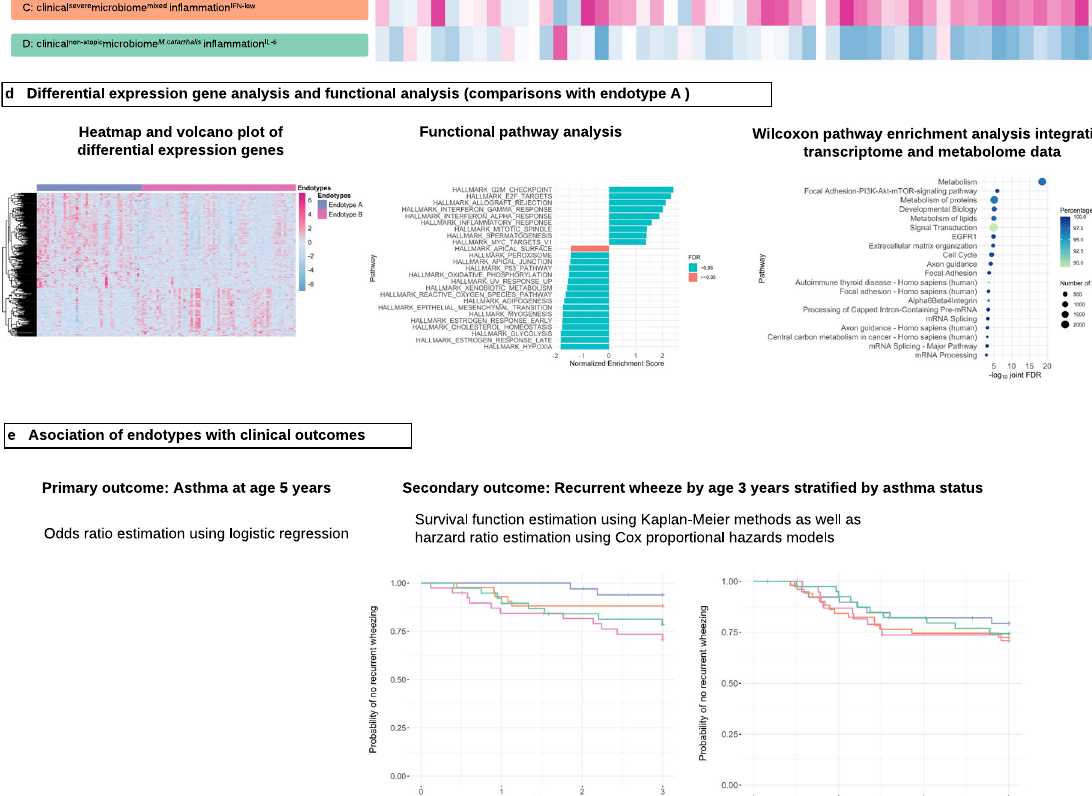
infants (clinical atopic microbiome S. pneumoniae / M. 6.00; 95% CI, 2.08 – 21.9; P = 0.002; Table 2) while those with an endotype C or D did not have signi fi cantly differential